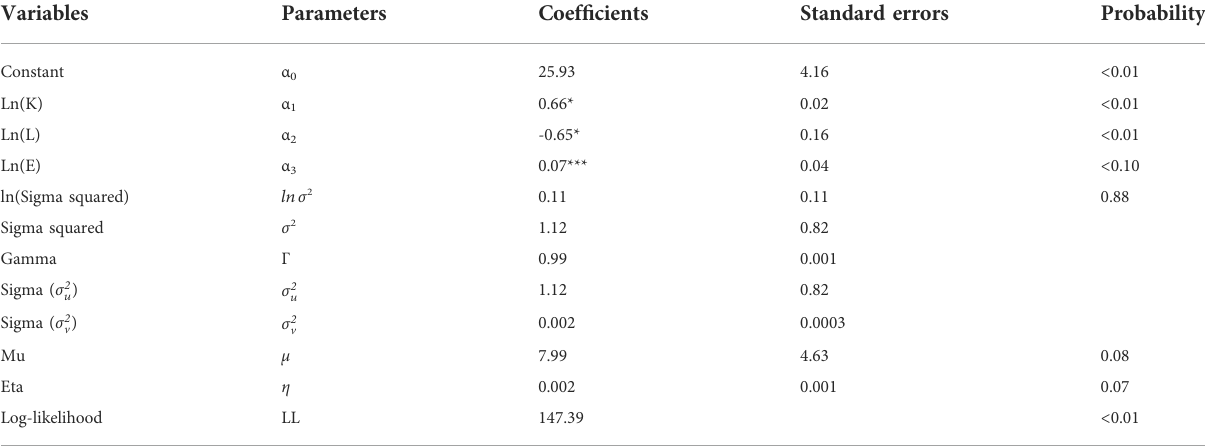
TABLE 3 Outcomes of maximum likelihood random effect time-varying ef fi ciency decay model.